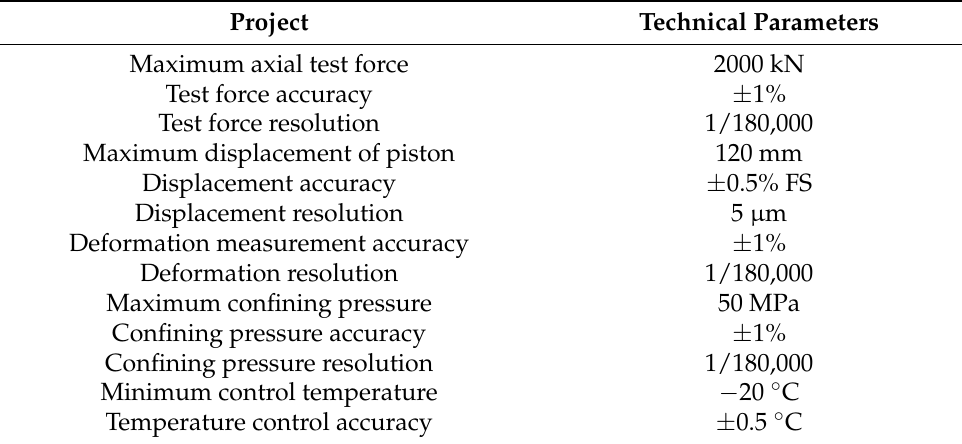
Table 2. Main technical parameters of ZTCR-2000 rock triaxial test